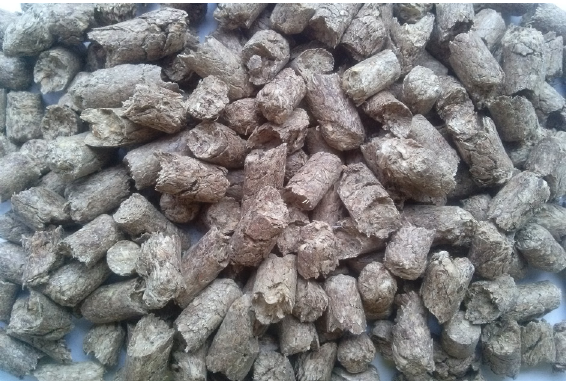
Figure 1: Giant knotweed pellets used as a raw material for activated carbons